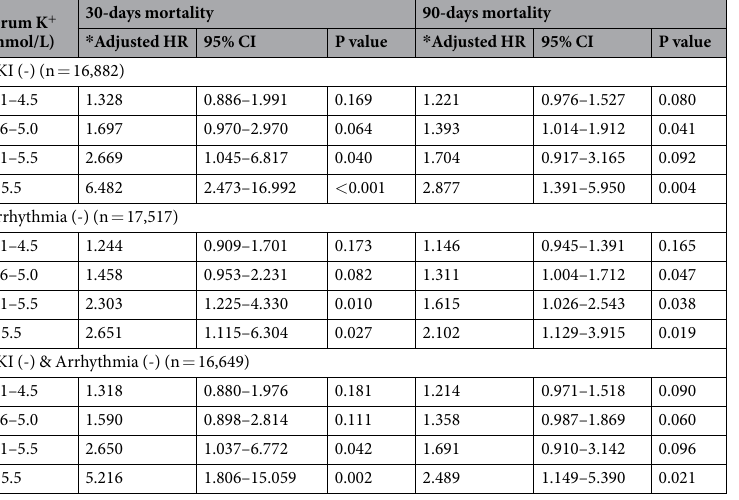
Table 3. Association of baseline serum K + range and mortality in patients without events of acute kidney injury or arrhythmia. HR, hazard ratio by Cox regression hazard model, CI, confidence interval, AKI, acute kidney injury. The reference range of the analysis was serum K + 3.6–4.0 mmol/L. * Adjusted with the following variables; age, sex, history of cancer, ischaemic heart disease, heart failure, hypertension, diabetes mellitus, baseline estimated GFR and total CO 2 , presence of hypoalbuminaemia (albumin level less than 3.5 g/dL), anaemia (haemoglobin level less than 11 g/dL), and baseline use of ACE I/ARBs, beta blockers, diuretics and NSAIDs. Baseline estimated GFR and total CO 2 were included in the analysis as continuous variables (natural unit), as the laboratory findings were directly related to levels of serum K + .